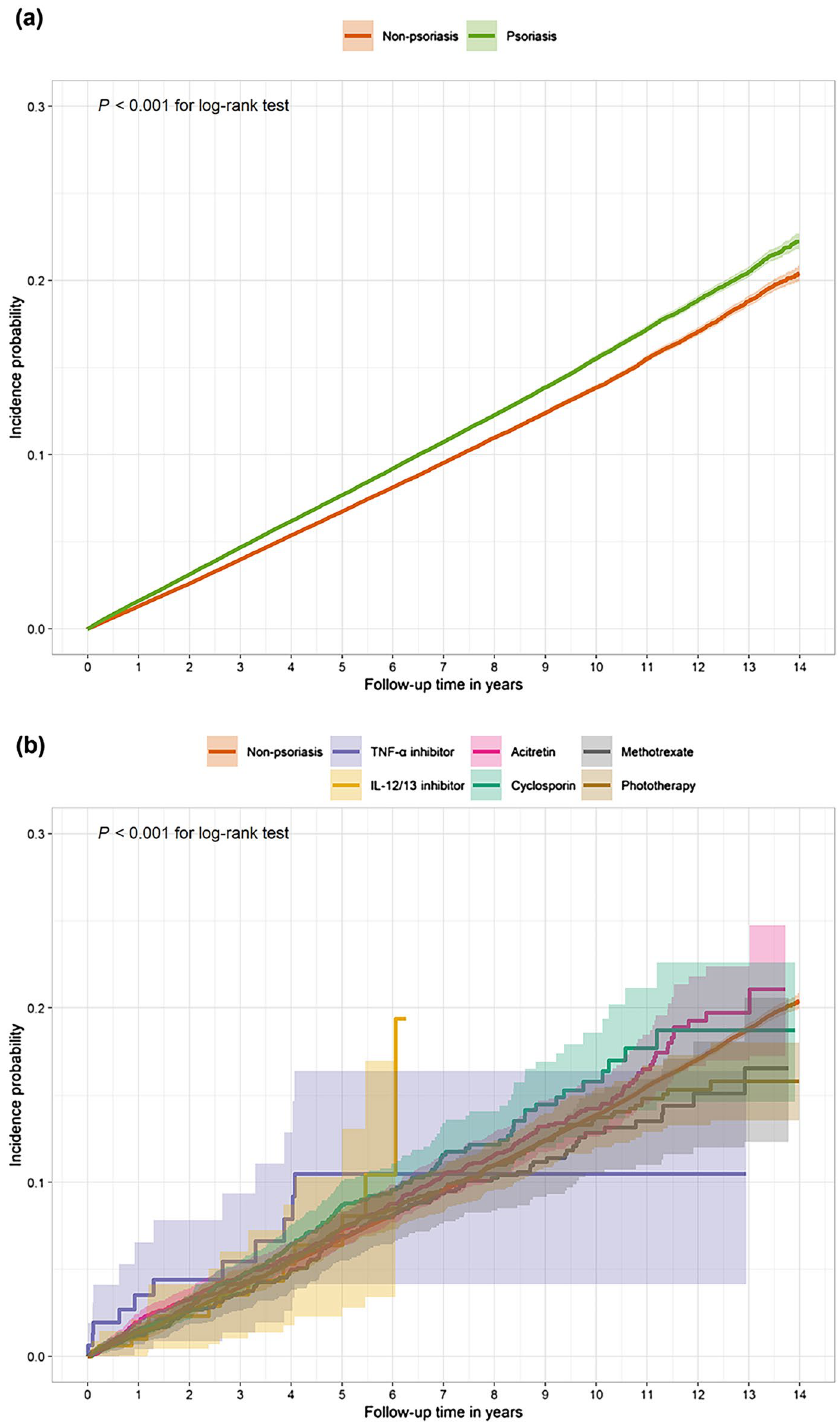
Figure 1. Incidence probabilities for psoriasis and non-psoriasis participants according to anti-psoriatic treatments. Comparison of Kaplan–Meier curve on malignancy without NMSC between ( a ) psoriasis and non-psoriasis participants and ( b ) psoriasis according to anti-psoriatic treatments and non-psoriasis participants. IL-12/23, interleukin-12/23; NMSC, nonmelanoma skin cancer; TNF-α, tumor necrosis